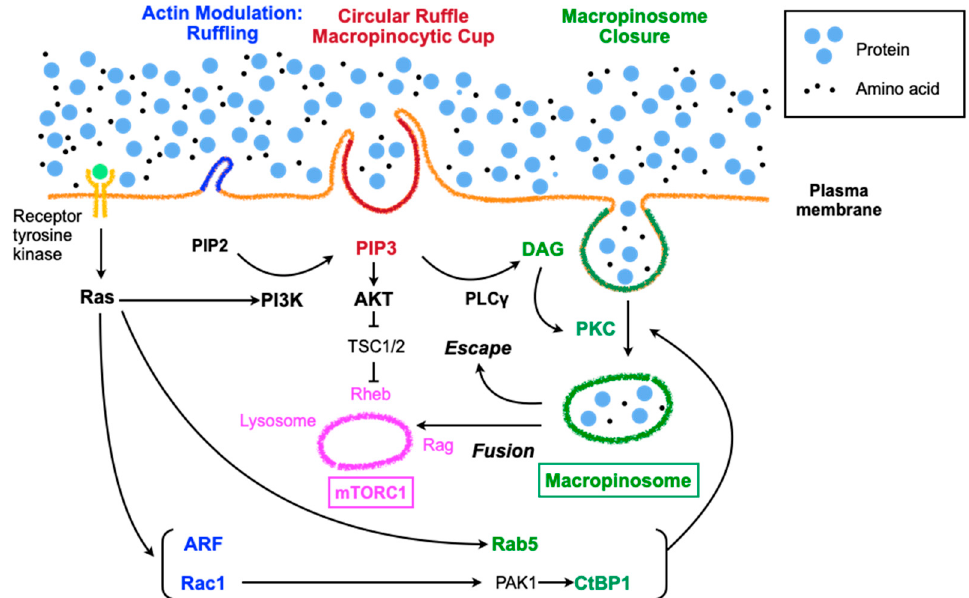
Figure 1. Regulation of macropinocytosis and the signaling pathways involving in mTORC share many molecules, but these molecules do not always function in parallel under various environmental stress conditions. PI3K: phosphoinositide 3-kinase, PIP2: phosphatidylinositol-4, 5-bisphosphate, TSC: tuberous sclerosis complex, DAG: diacylglycerol, PKC: protein kinase C, PLC: phospholipase C.